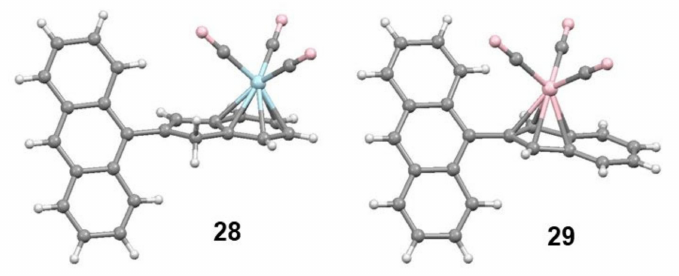
Figure 12. Molecular structures of [ η 6 -2-(9-anthracenyl)indene]tricarbonylchromium, 28 , and [ η 5 -2-(9- anthracenyl)indenyl]tricarbonylrhenium, 29